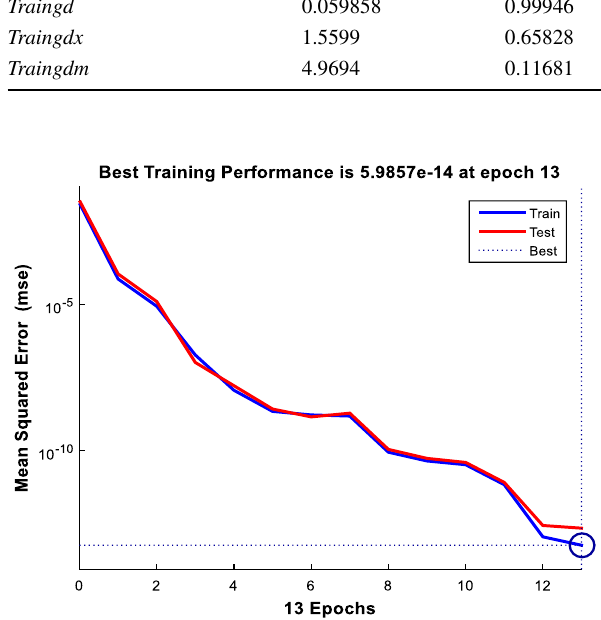
Fig. 7 Mean squared error (ANN) for chromium(VI) removal